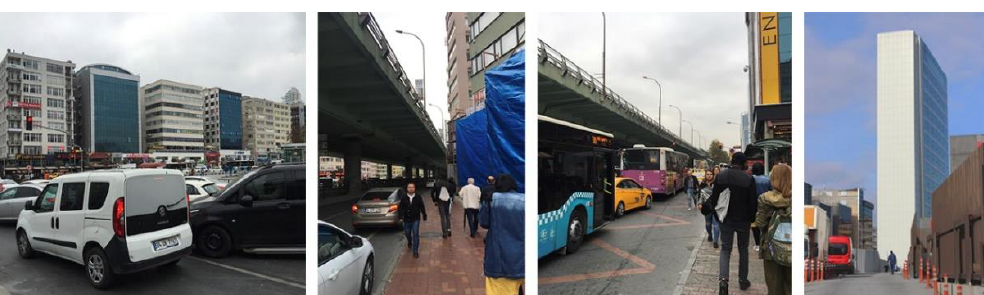
Figure 3 Problems related with pedestrian accessibility in Mecidiyeköy (Photograph credits: personal archive of Feride Gül Keleş, 2019 and Url -5).